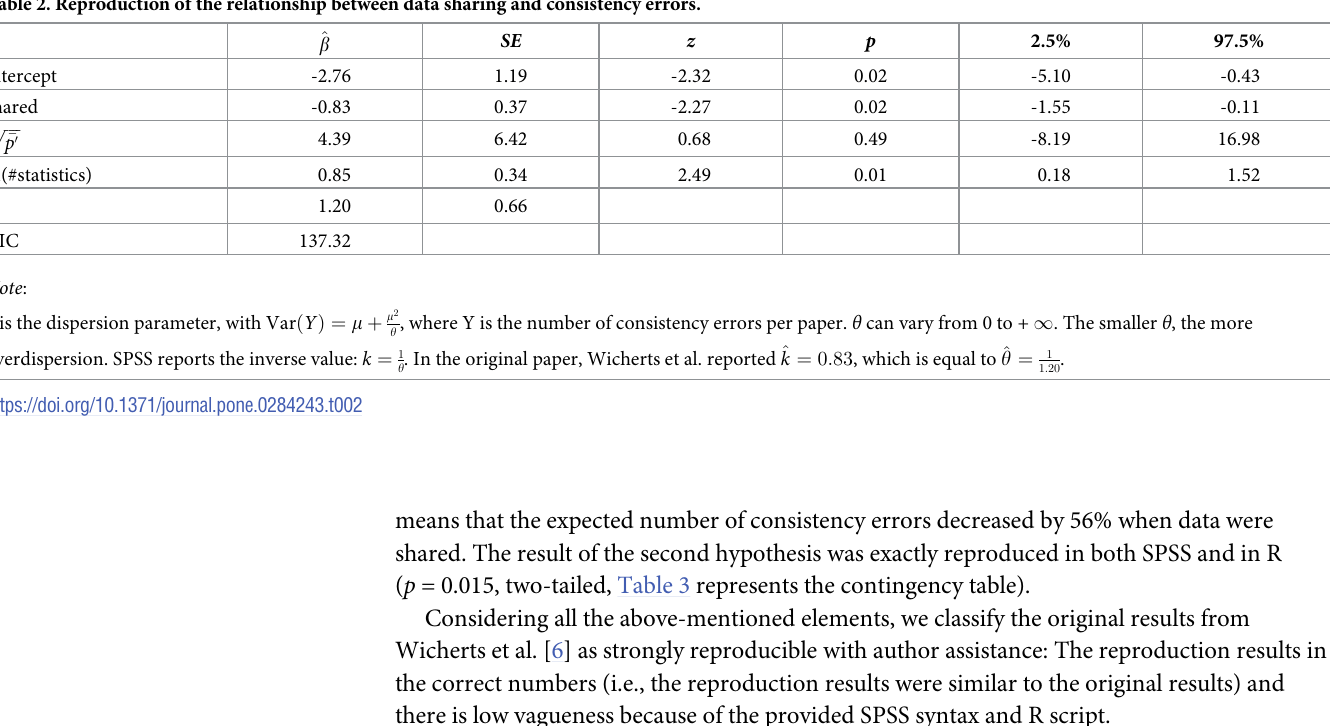
Table 2. Reproduction of the relationship between data sharing and consistency errors.